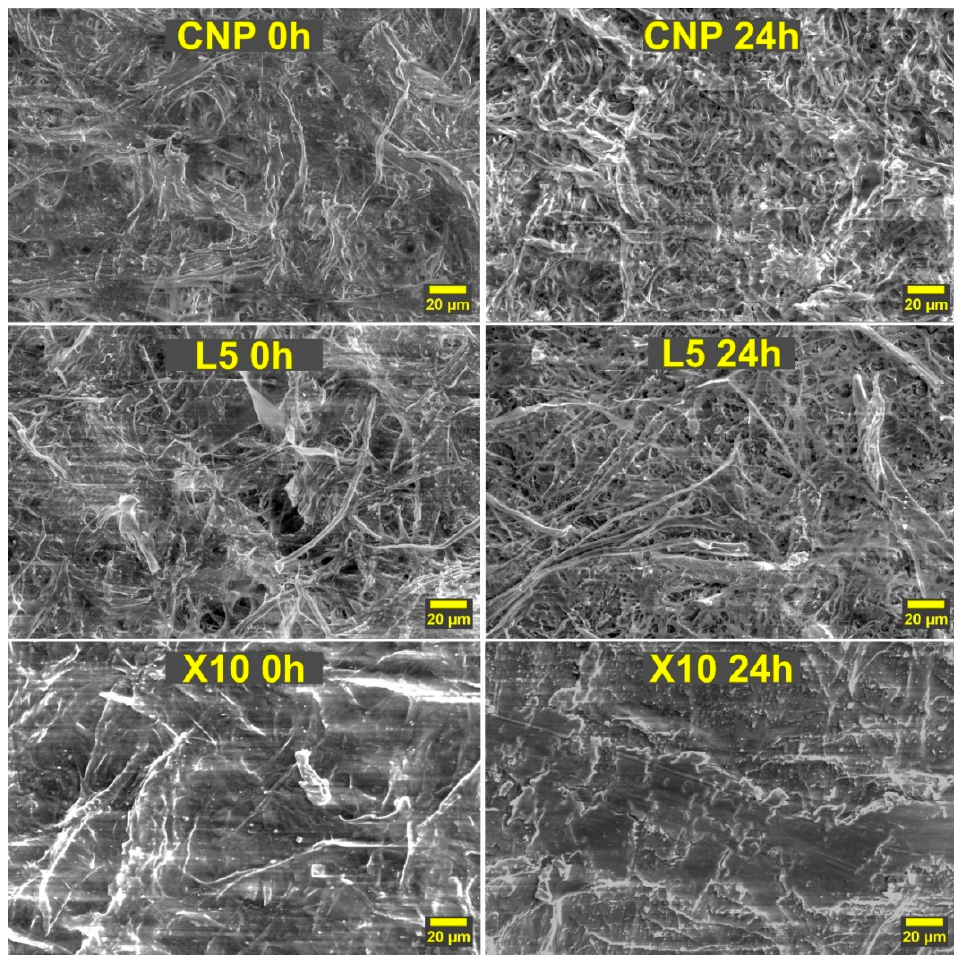
Figure 7. The impact of 24 h of UV irradiation on the surface morphologies of selected NP compositions.